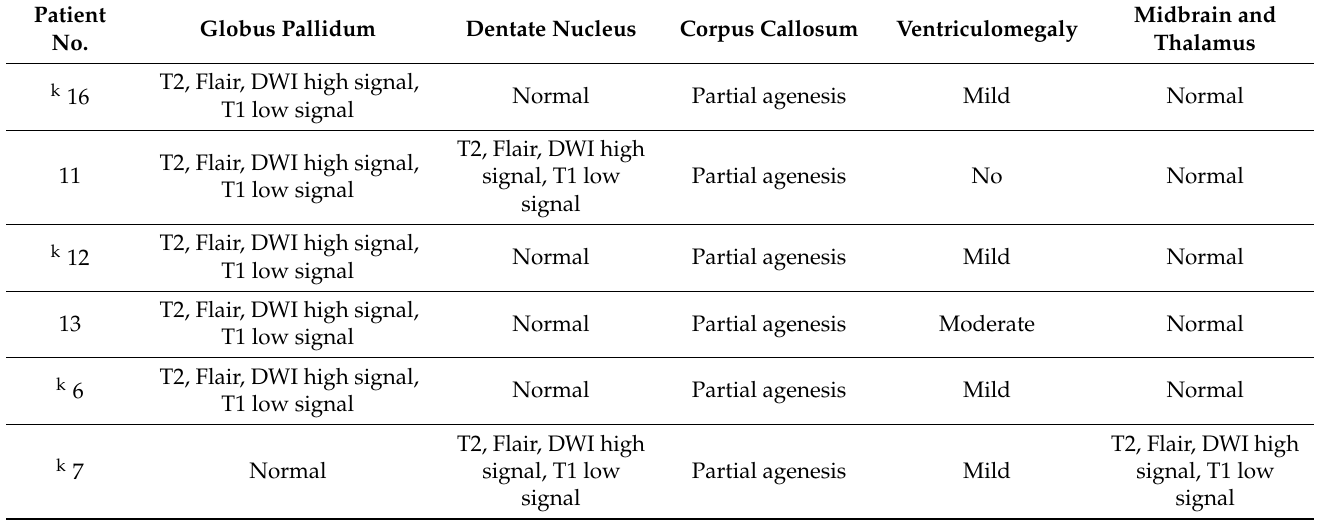
Table 5. Imaging studies of patients 6,7,